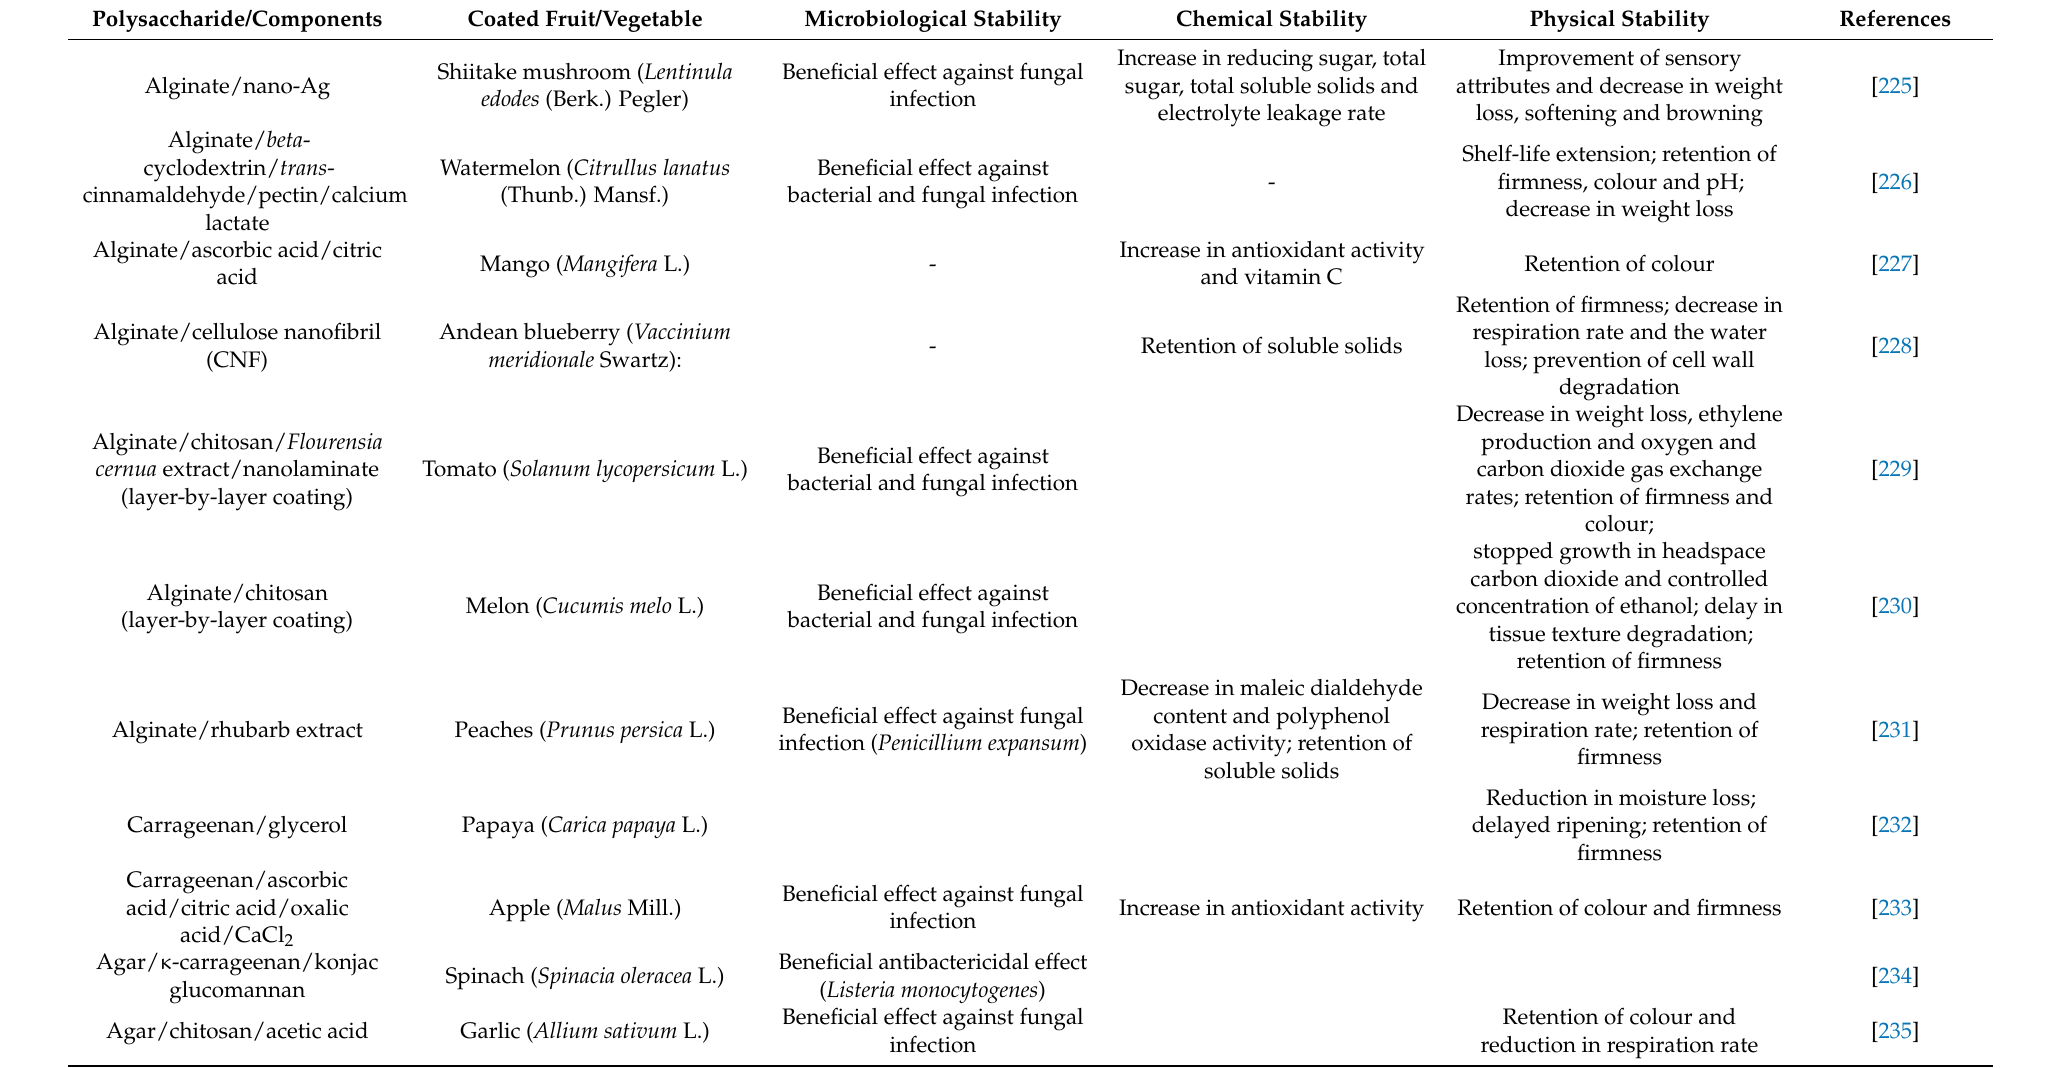
Table 5. Effect of edible films and coatings on the quality of fruits and